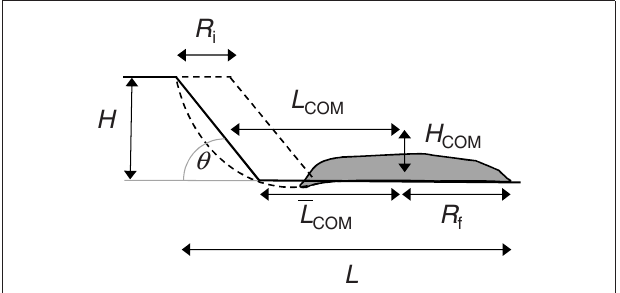
FIGURE 1 | Geometry of the landslide model. The dashed line identifies the region of the original slope that was removed by the landslide. The shaded area is the final deposit of the landslide. Calculation of the total runout L is divided in two sub-problems: (a) the center-of-mass runout L COM and (b) the initial and final spreads R i and R f . L COM is derived from an analytical solution for granular flow of constant thickness on an inclined plane. Spreading of the landslide due to its flattening is included in the calculation of R f .